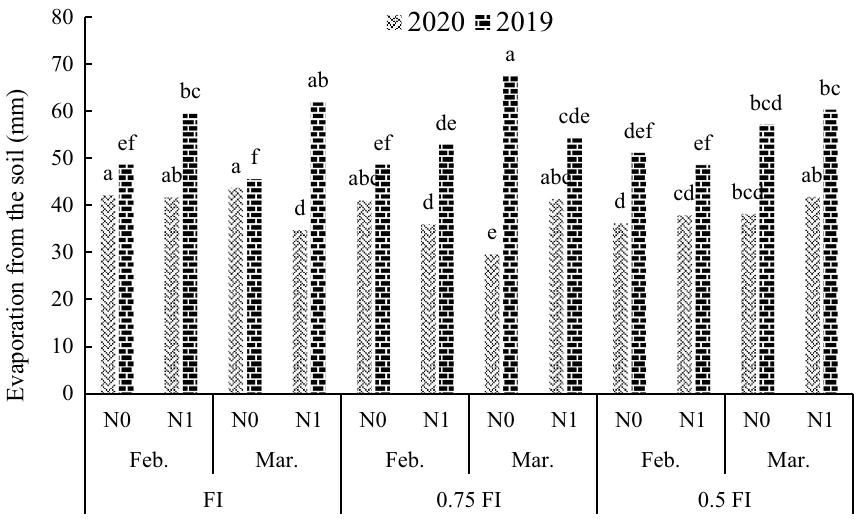
Figure 5. The effect of irrigation × sowing date × fertilizer on soil evaporation in two years. FI: full irrigation, N: nitrogen, Feb: February, Mar: March. Means with different letters did differ significantly.